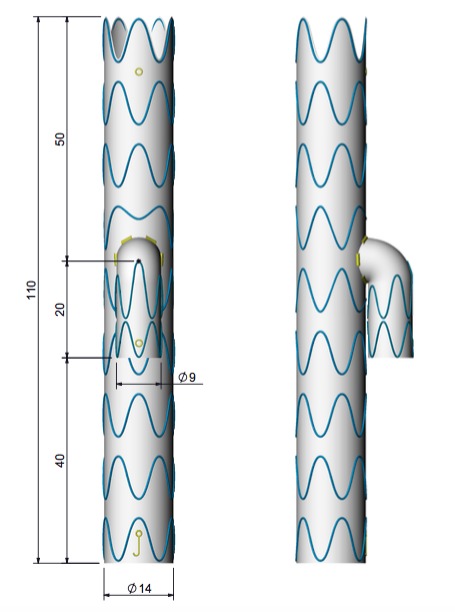
Initial design of customized endoprosthesis with iliac branch.